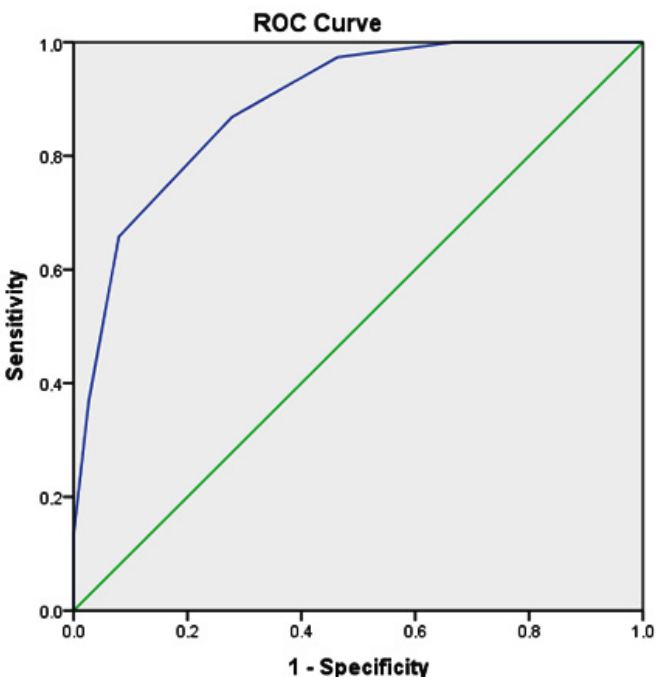
Figure 1. Recipient-operator curve (ROC) analysis represents the curve obtained to differentiate patients who have perforated versus those who have simple appendicitis (AUC = 0.80; 95% CI: 0.719 – 0.871; p < 0.001).